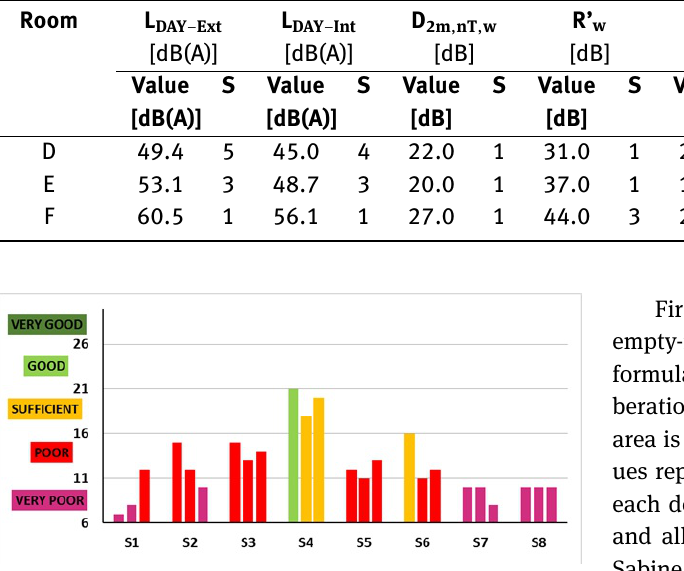
Figure 5: Global Noise Score for the classrooms of GIOCONDA